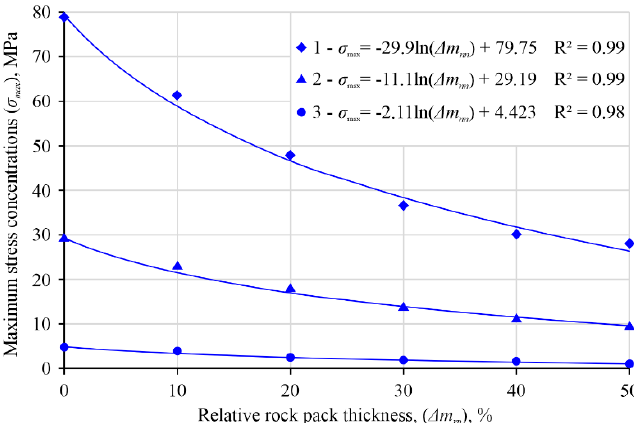
Figure 7. Dependence of a change in the maximum stress concentrations of rock layers in the destressing zone on the relative rock pack thickness: 1—sandstone ( у = 45 m); 2—siltstone ( у = 42 m); 3—argillite ( у = 29 m).